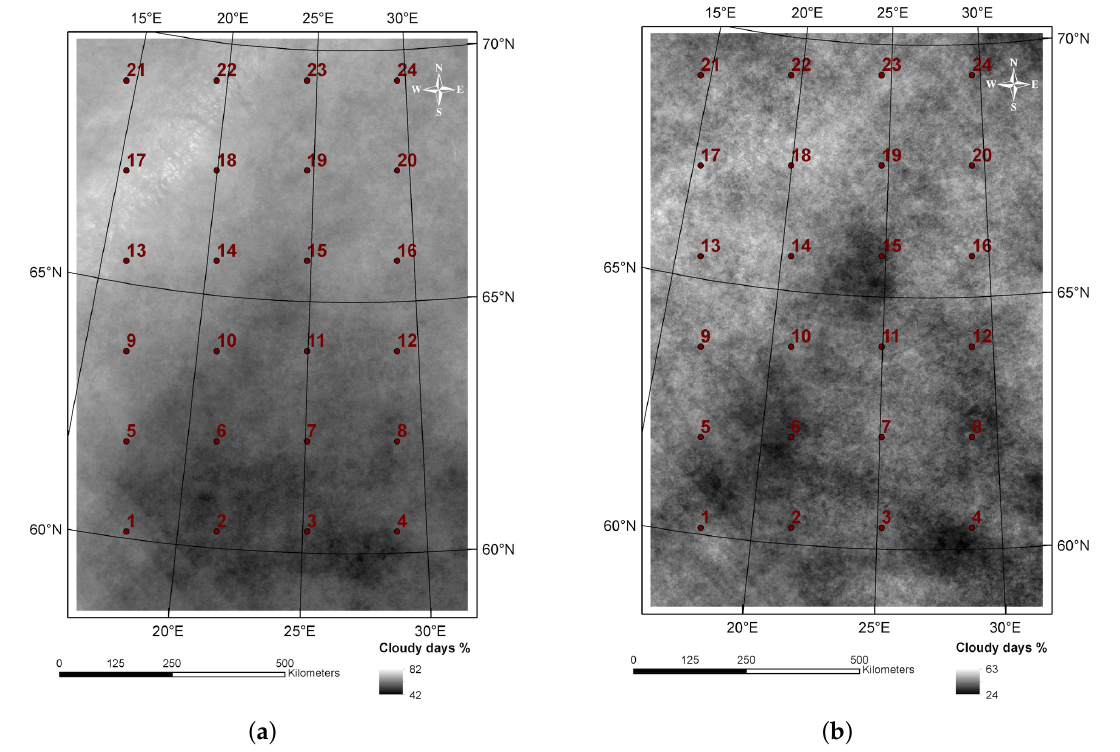
Figure 8. Cloudy days percentages computed on the whole Suomi NPP VIIRS dataset ( a ) and on summertime images ( b ). The numbered points from 1 to 24 are the visually interpreted reference